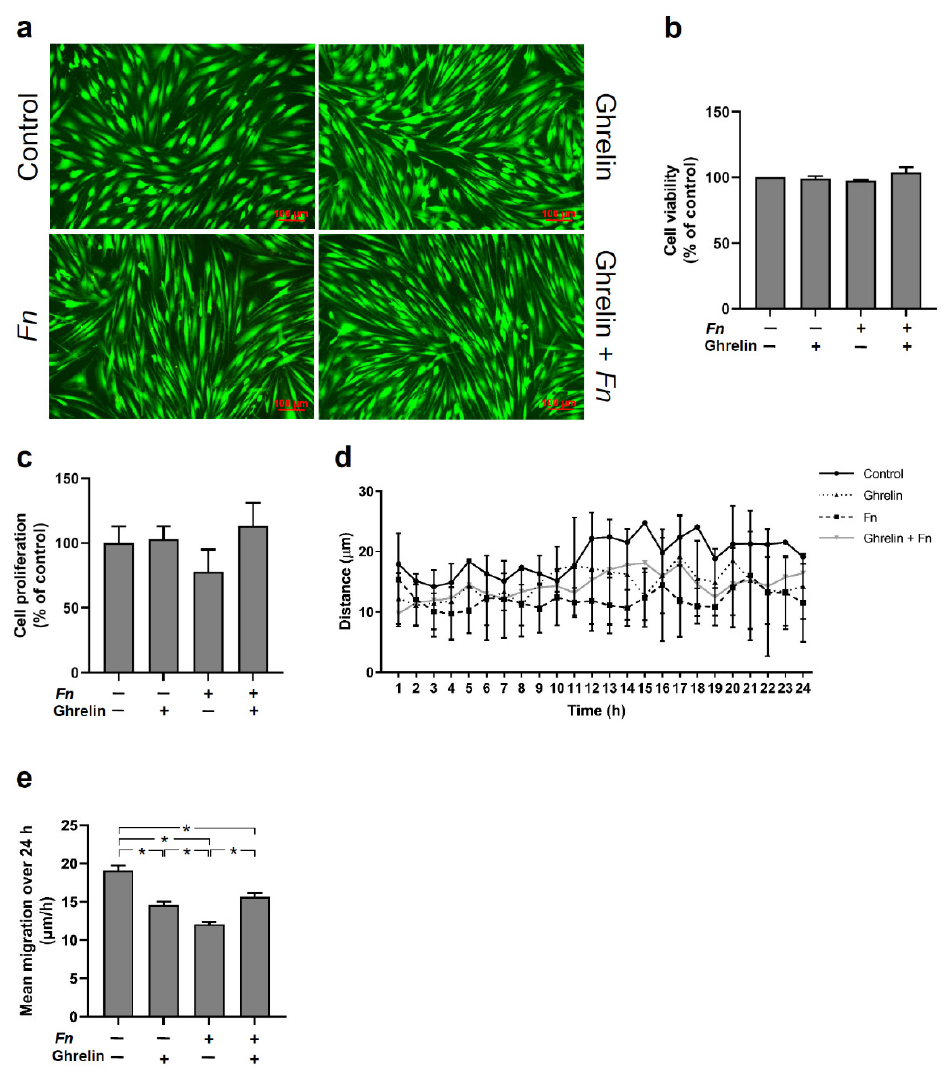
Figure 6. ( a ) Viability of HGFs in the presence or absence of F. nucleatum ( Fn ATCC 25586; OD 660 : 0.1) and/or ghrelin (20 nM) at 2 d. Images are from one representative donor. ( b ) Percentage of cell viability in the presence (+) or absence ( − ) of F. nucleatum ( Fn ATCC 25586; OD 660 : 0.1) and/or ghrelin (20 nM) at 2 d. Mean ± SEM (n = 6). ( c ) Percentage of cell proliferation in the presence (+) or absence ( − ) of F. nucleatum ( Fn ATCC 25586; OD 660 : 0.1) and/or ghrelin (20 nM) at 2 d. Mean ± SEM (n = 6). ( d ) Migration of HGFs in the presence or absence of F. nucleatum ( Fn ATCC 25586; OD 660 : 0.1) and/or ghrelin (20 nM) at 2 d (n = 18) measured per hour during 24 h. ( e ) Mean migration of HGFs shown in d in the presence (+) or absence ( − ) of F. nucleatum ( Fn ATCC 25586; OD 660 : 0.1) and/or ghrelin (20 nM) over 24 h. Mean ± SEM. * Significant ( p < 0.05) difference between groups. Unstimulated cells served as